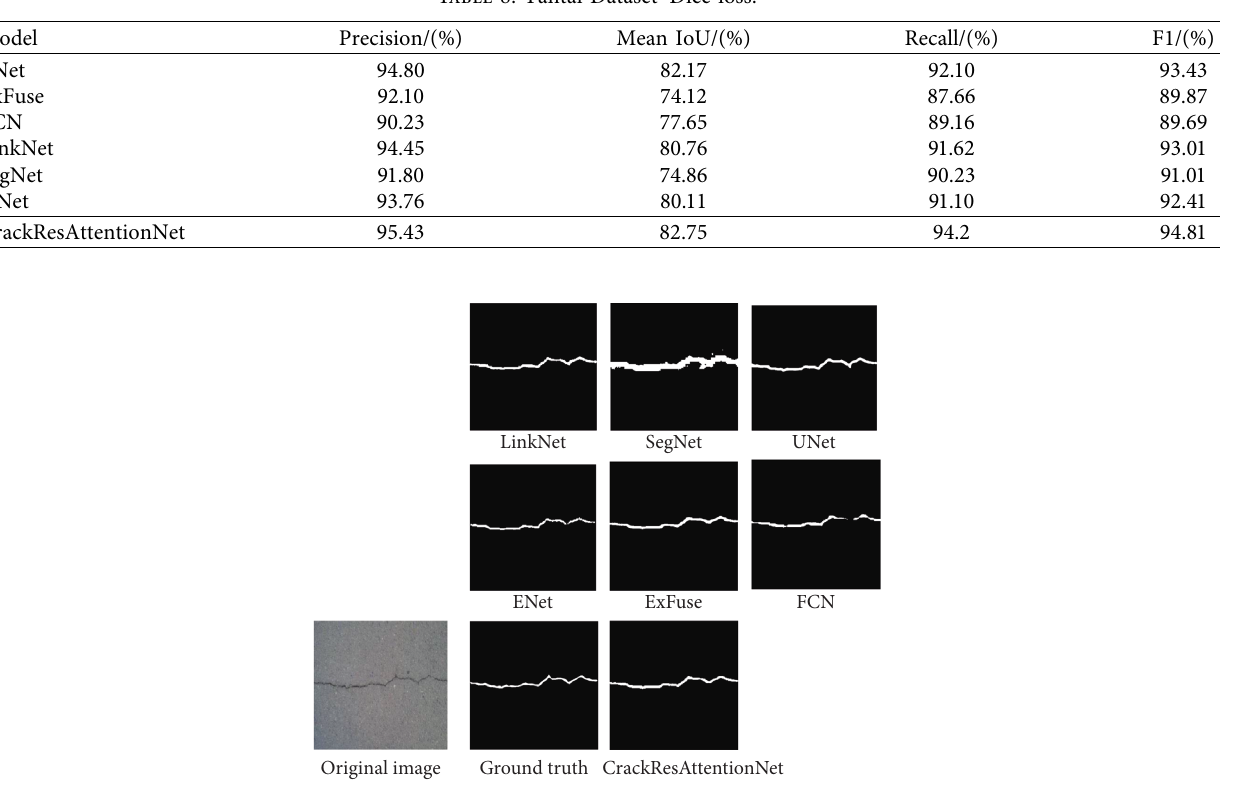
Figure 8: Public Crack Dataset Sample Prediction-BCE loss.